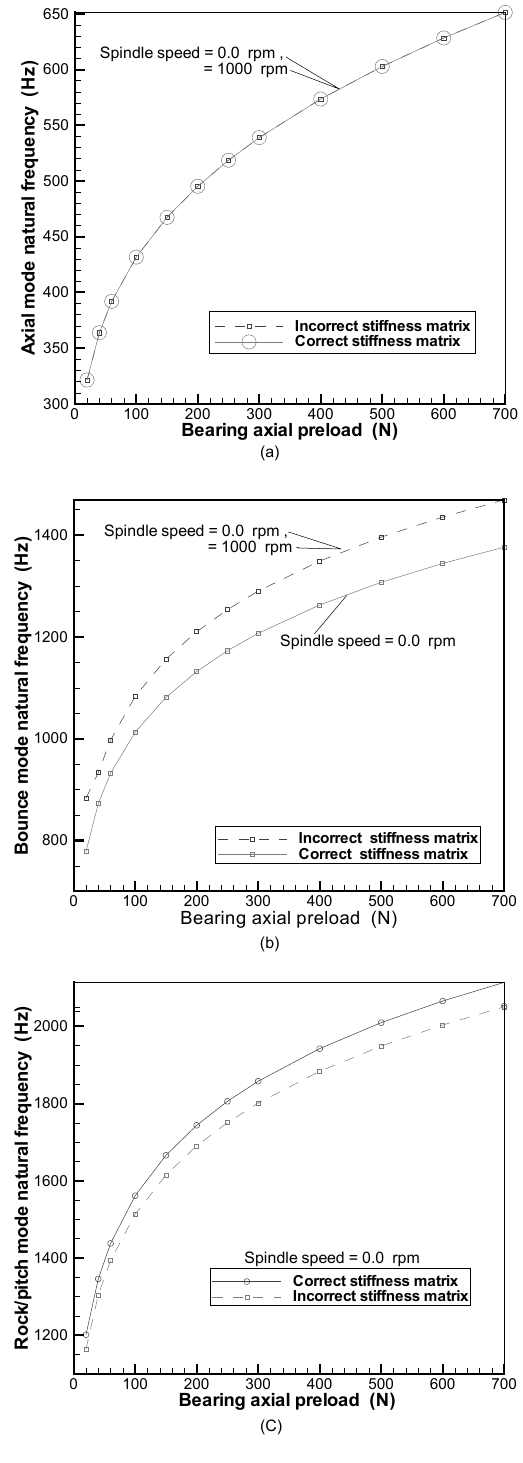
Fig. 8. Natural frequencies of the machine spindle-bearings assembly vs bearing axial preload with consideration of shaft gyroscopic effect ( Ω s = 1000 rpm) and without gyroscopic effect ( Ω s = 0.0 rpm): (a) axail frequency; (b) bounce frequency; (c) rock/pitch